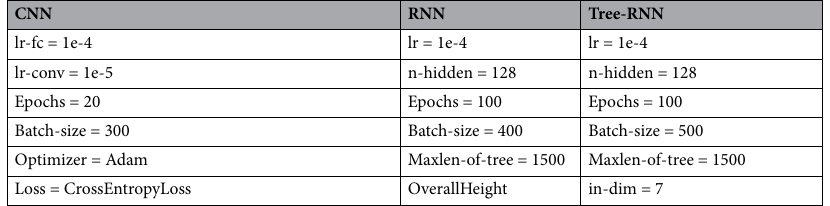
Table 2. The hyperparameters for the CNN, RNN, and Tree-RNN.